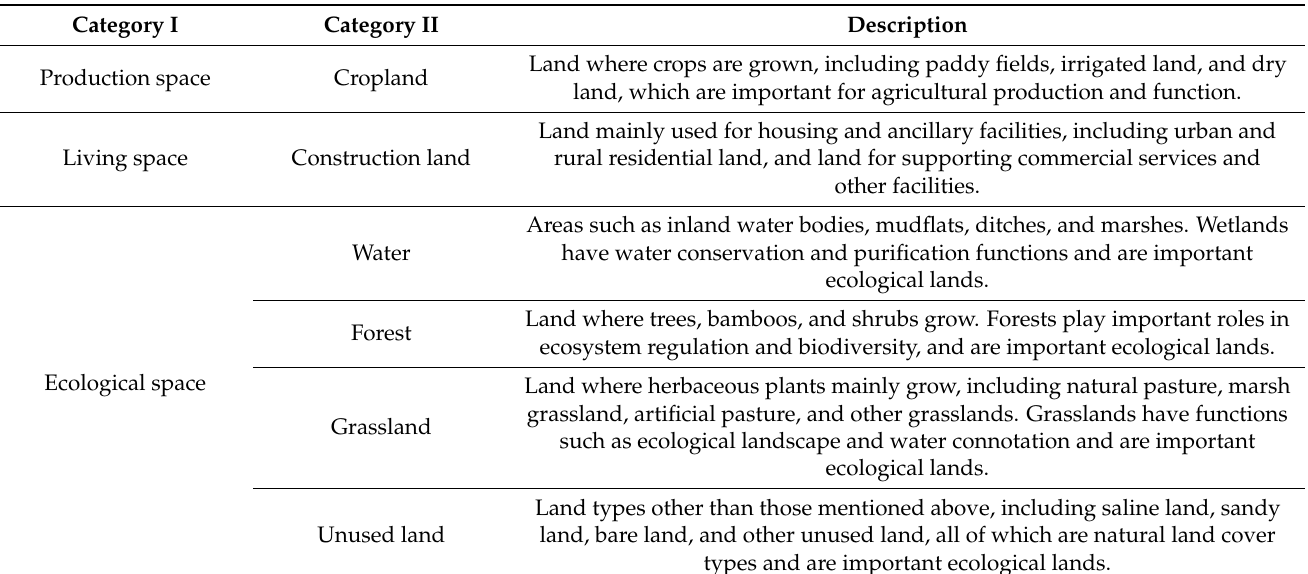
Table 2. The spatial classification system for the PYL